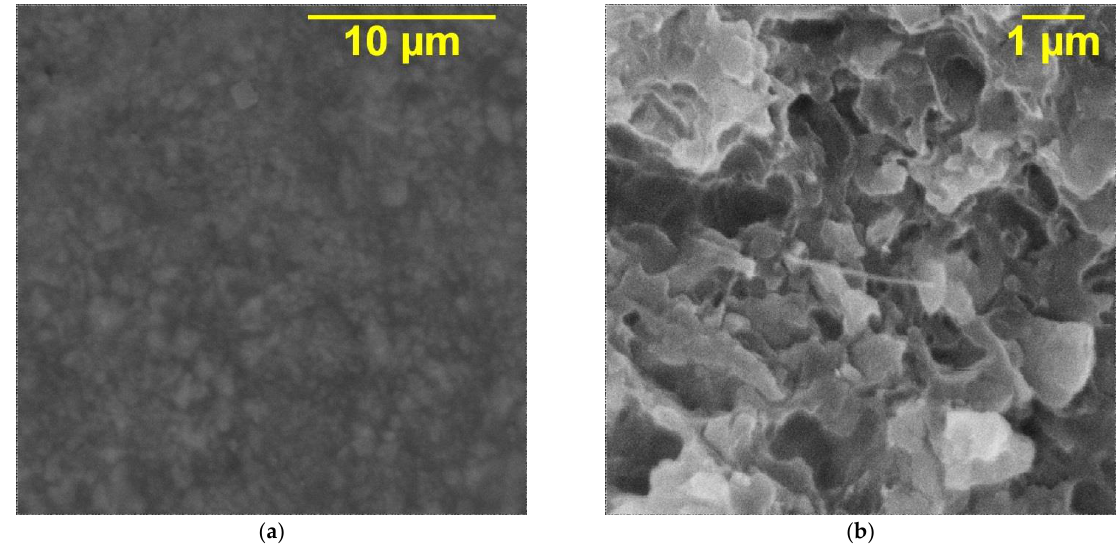
Figure 6. SEM microphotographs of ( a ) surface and ( b ) cross-section of three-phase composites of KFTO(H)/MWCNTs/PVDF with 30 vol.% of filler.